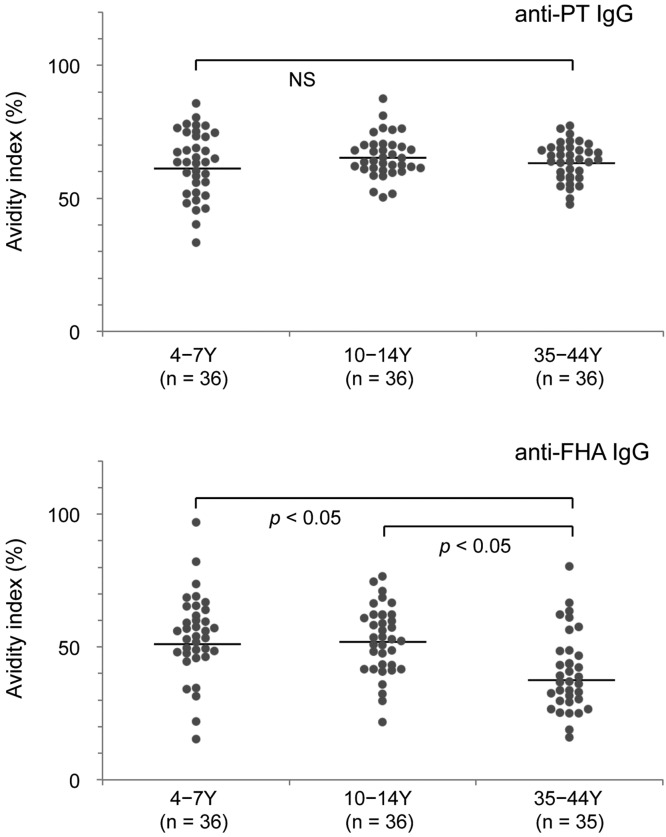
Avidities of anti-PT IgG and anti-FHA IgG among young children, older children, and adults.The avidity indexes (AI) were determined in IgG fractions that were purified from serum samples, which were collected in 2014. The age groups were 4–7 years, 10–14 years, and 35–44 years. Bars indicate the geometric mean AI values. Numbers in parentheses indicate the number of samples that were analyzed. Y, years; NS, not significant. P-values were determined using the Steel-Dwass test.